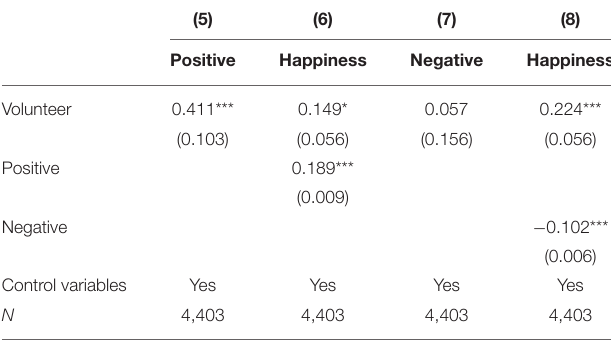
TABLE 7 | Test results of mediating